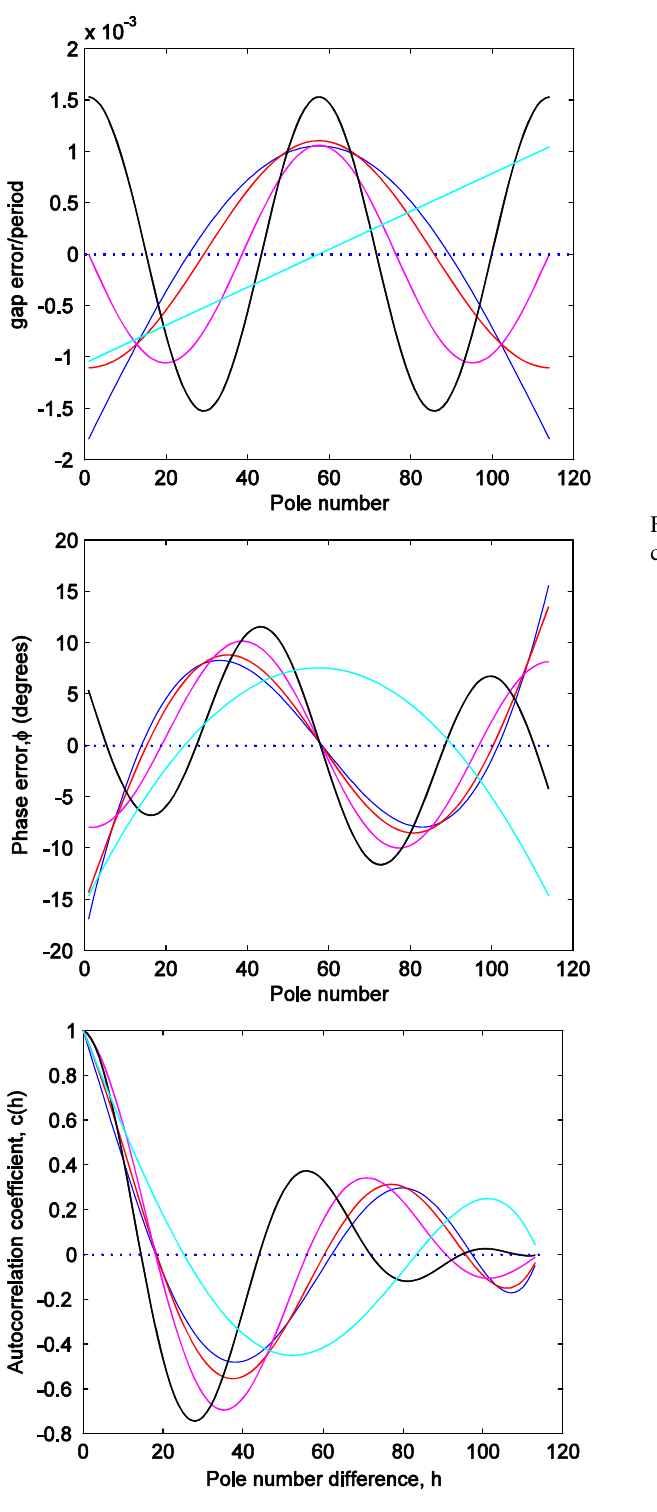
(lower).FIG. 3. Gap errors (upper), corresponding phase errors (middle), and their autocorrelation functions (lower) for a linear taper (cyan) and 0.5 (blue), 1 (red), 1.5 (magenta), and 2 (black) periods of a cosine function along the length of a device The gap errors are scaled to produce the same rms phase error in each ¼ 6 : 7 (cid:2) case, (cid:1) ’